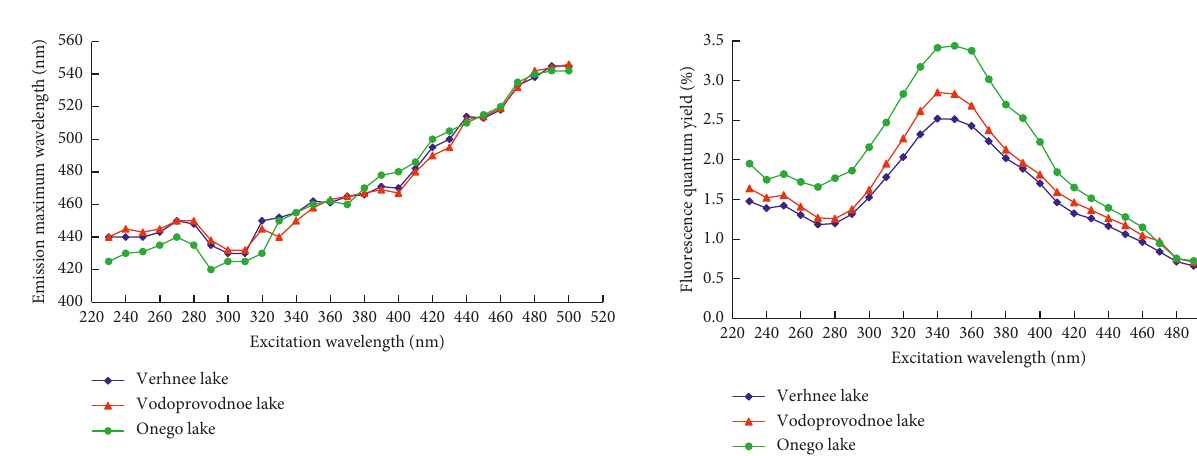
Figure 3: Emission maximum wavelength for the humic-like fluorescence as dependence on excitation wavelength for CDOM samples from three Karelian lakes.